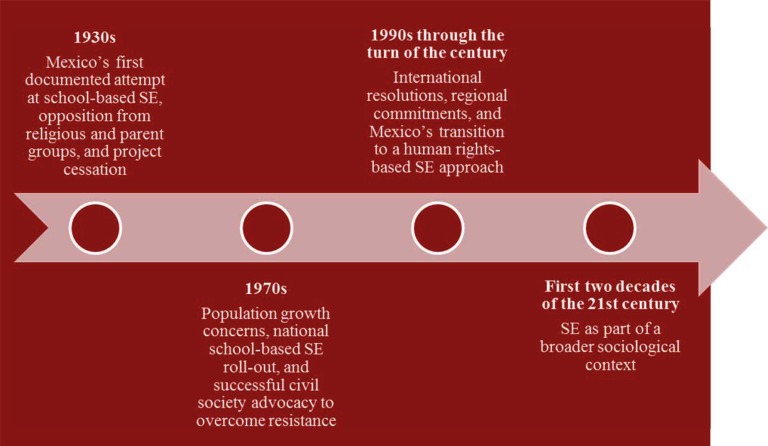
Historical Time Periods of the Evolution of Sexuality Education in MexicoAbbreviation: SE, sexuality education.